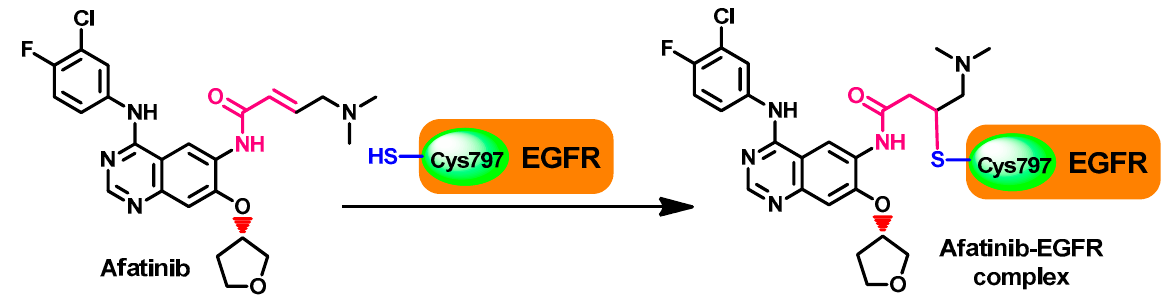
Figure 11. Mechanism of the irreversible inhibition of EGFR by afatinib.